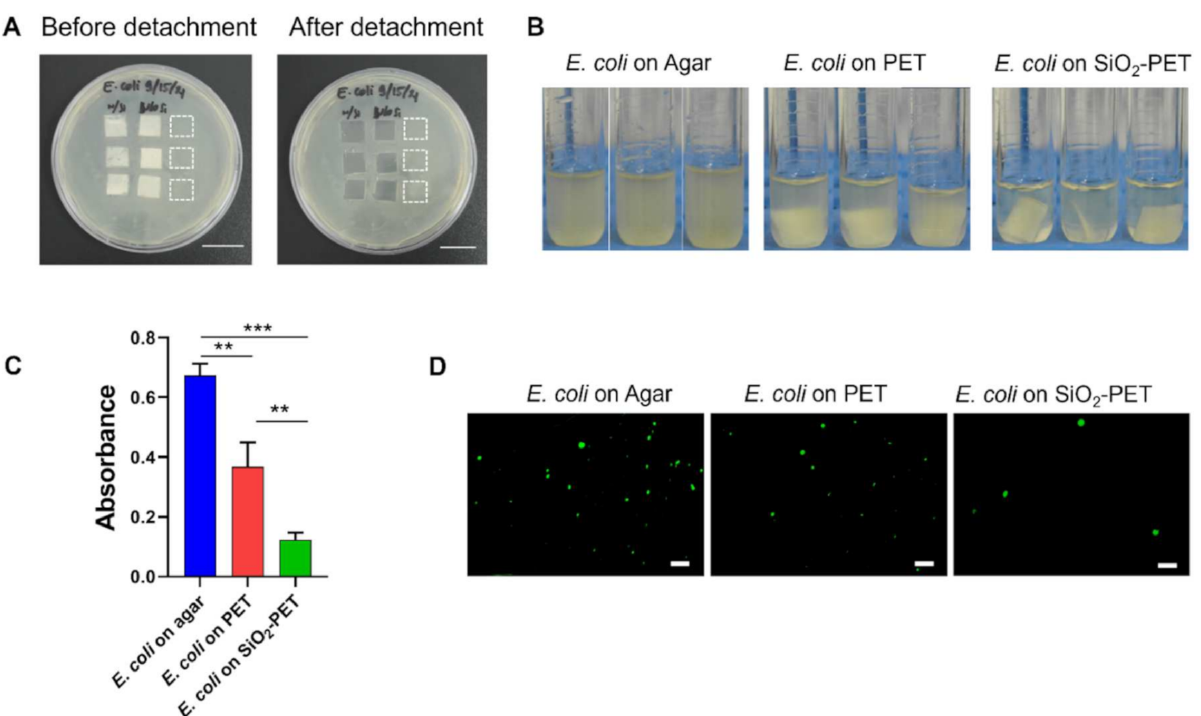
Figure 4. Assessment of the antibacterial properties of electrosprayed SiO 2 films against E. coli . ( A ) Images of agar plates before and after film detachment (scale bar: 20 mm). ( B ) Images of detached films and agar in LB broth after vortexing for 1 min. ( C ) Quantitative analysis of the detached films based on absorbance at 600 nm (OD 600 ). ** p < 0.01, *** p < 0.001. ( D ) Fluorescence images of live E. coli on the surface (scale bar: 200 µ